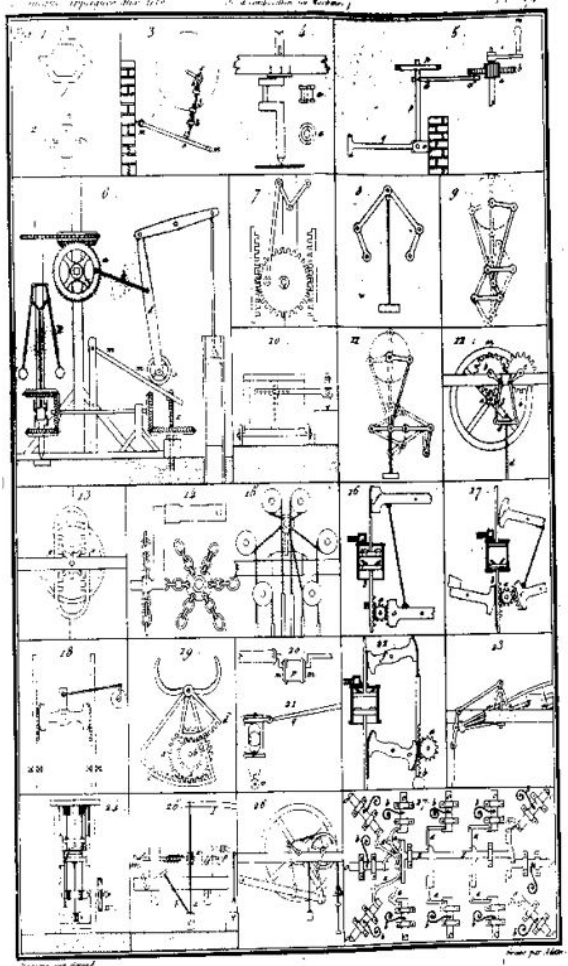
Figure 10. Part of a table of the classification of mecha- nisms by Gian Antonio Borgnis [71].